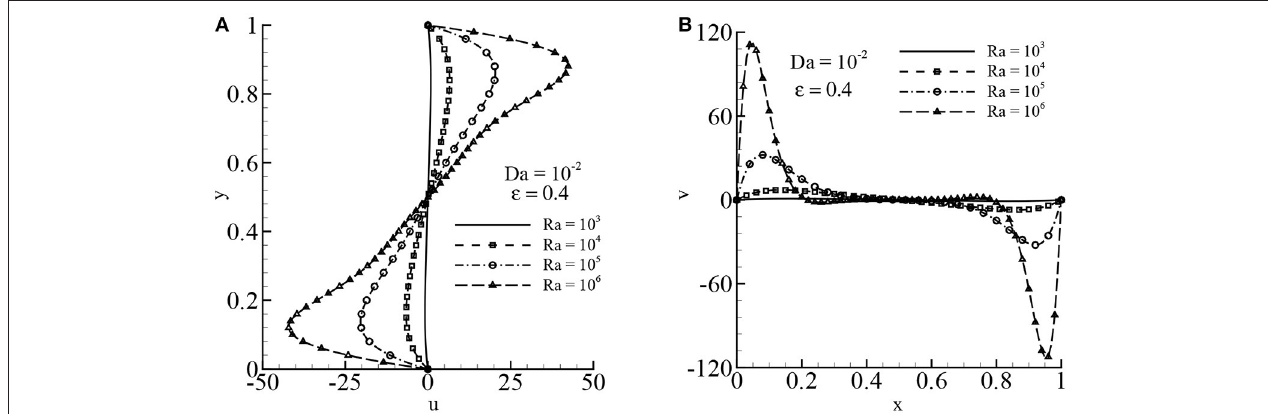
FIGURE 10 | Velocity distribution: (A) u -velocity and (B) v -velocity for different values of Ra while Pr